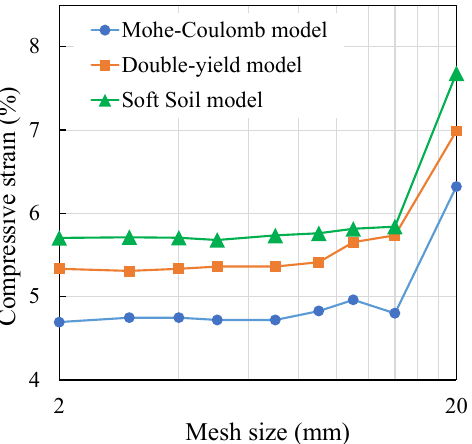
Figure A11. Variation of compressive strain under an applied stress of 500 kPa in one-dimensional consolidation simulations as functions of the mesh size.